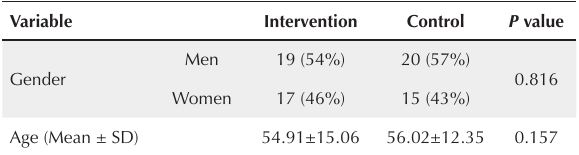
Table 1. Demographic characterization of participants